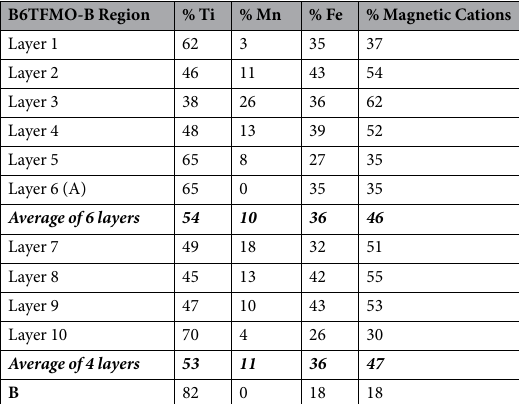
Table 1. The relative B-site proportions of Ti, Mn and Fe quantified by taking horizontal line profiles of the EDX data across regions indicated in Fig.